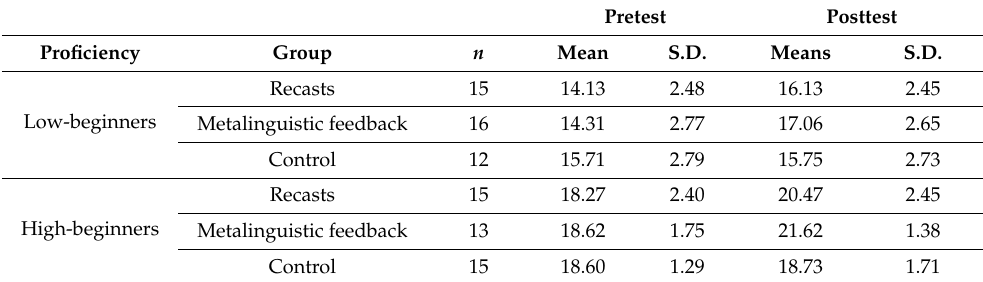
Table 4. Students’ performance in the pretest and the posttest in each proficiency group.